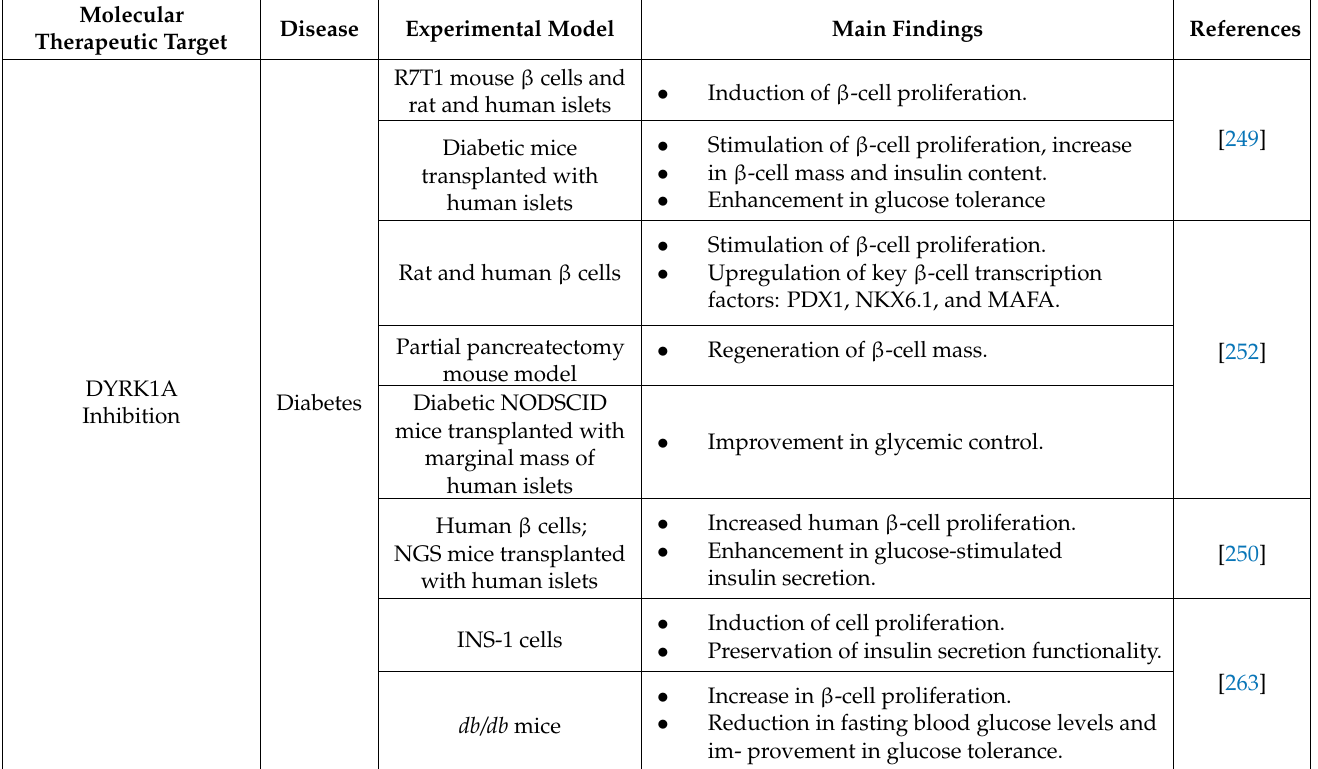
Table 2. Inhibition of DYRK1A as a therapeutic approach for diabetes and AD. Molecular Therapeutic